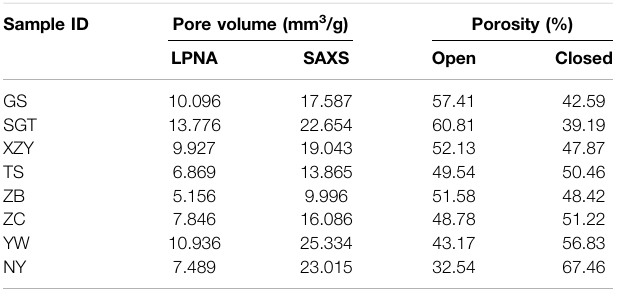
TABLE 5 | Pore volume, open/closed porosity obtained from LTNA and SAXS experiments. Sample ID